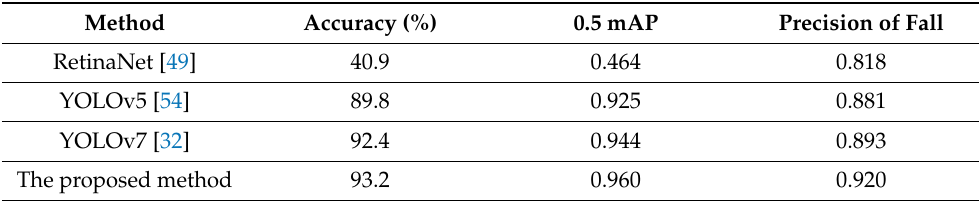
Table 6. Testing Performance of different models in UR Fall detection